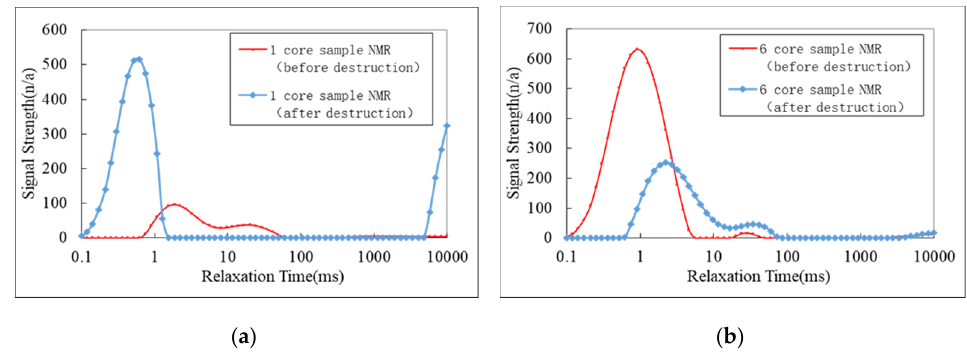
Figure 18. Typical T2 spectra of cores before and after triaxial compression. ( a ) Sample 1, ( b ) sample 6.